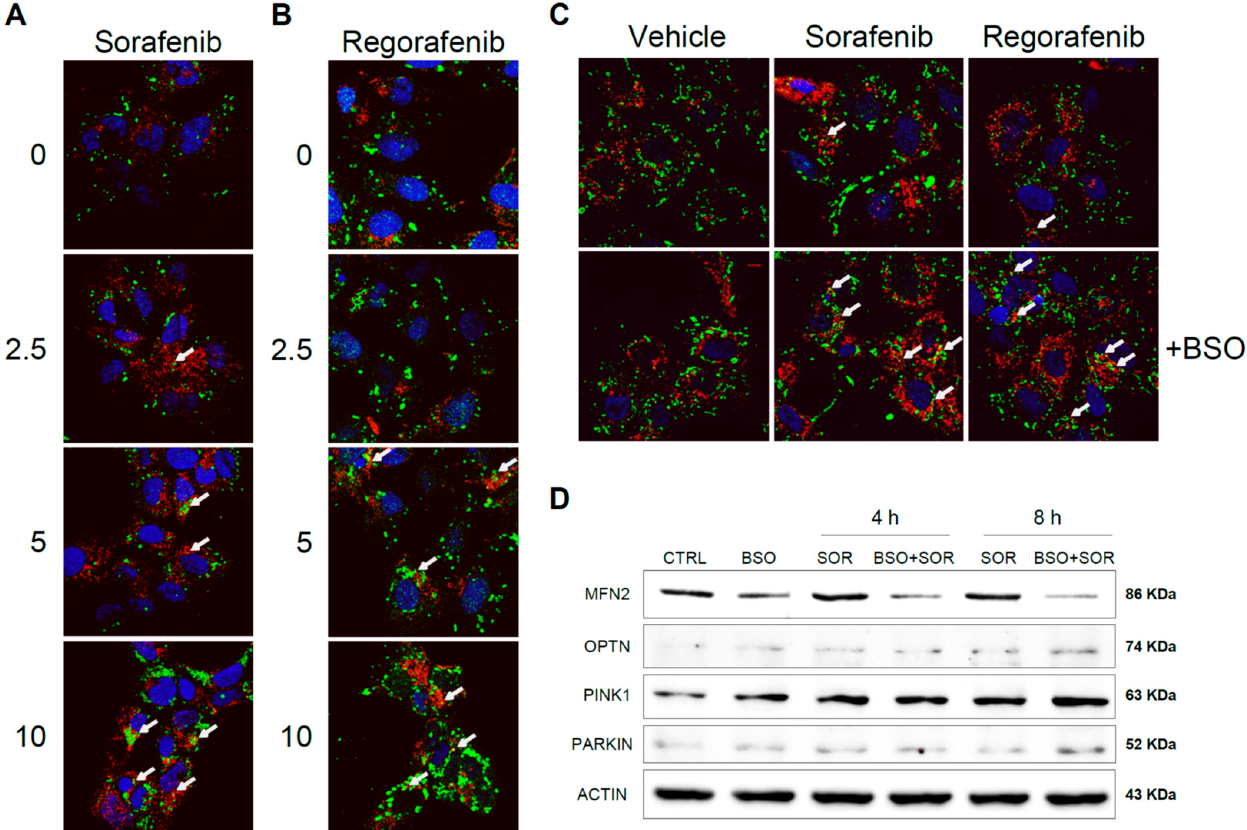
Figure 7. Sorafenib and regorafenib induced mitochondrial-ROS dependent mitophagy in hepatoma cells. Hep3B cells were treated with increasing doses of sorafenib ( A ) or regorafenib ( B ), stained with LC3 (red) and PDHA1 (green) antibodies and visualized by confocal microscopy after 16 h. Representative images of 12 independent random fields. ( C ) Hep3B cells pre-incubated with vehicle or BSO were treated with sorafenib (2.5 µM) or regorafenib (2.5 µM) and visualized as before. ( D ) Hep3B cells, incubated with vehicle or BSO, were treated with sorafenib (2.5 µM) at different times and different mitophagy-related proteins were analyzed by western blot. Representative images ( n = 3).